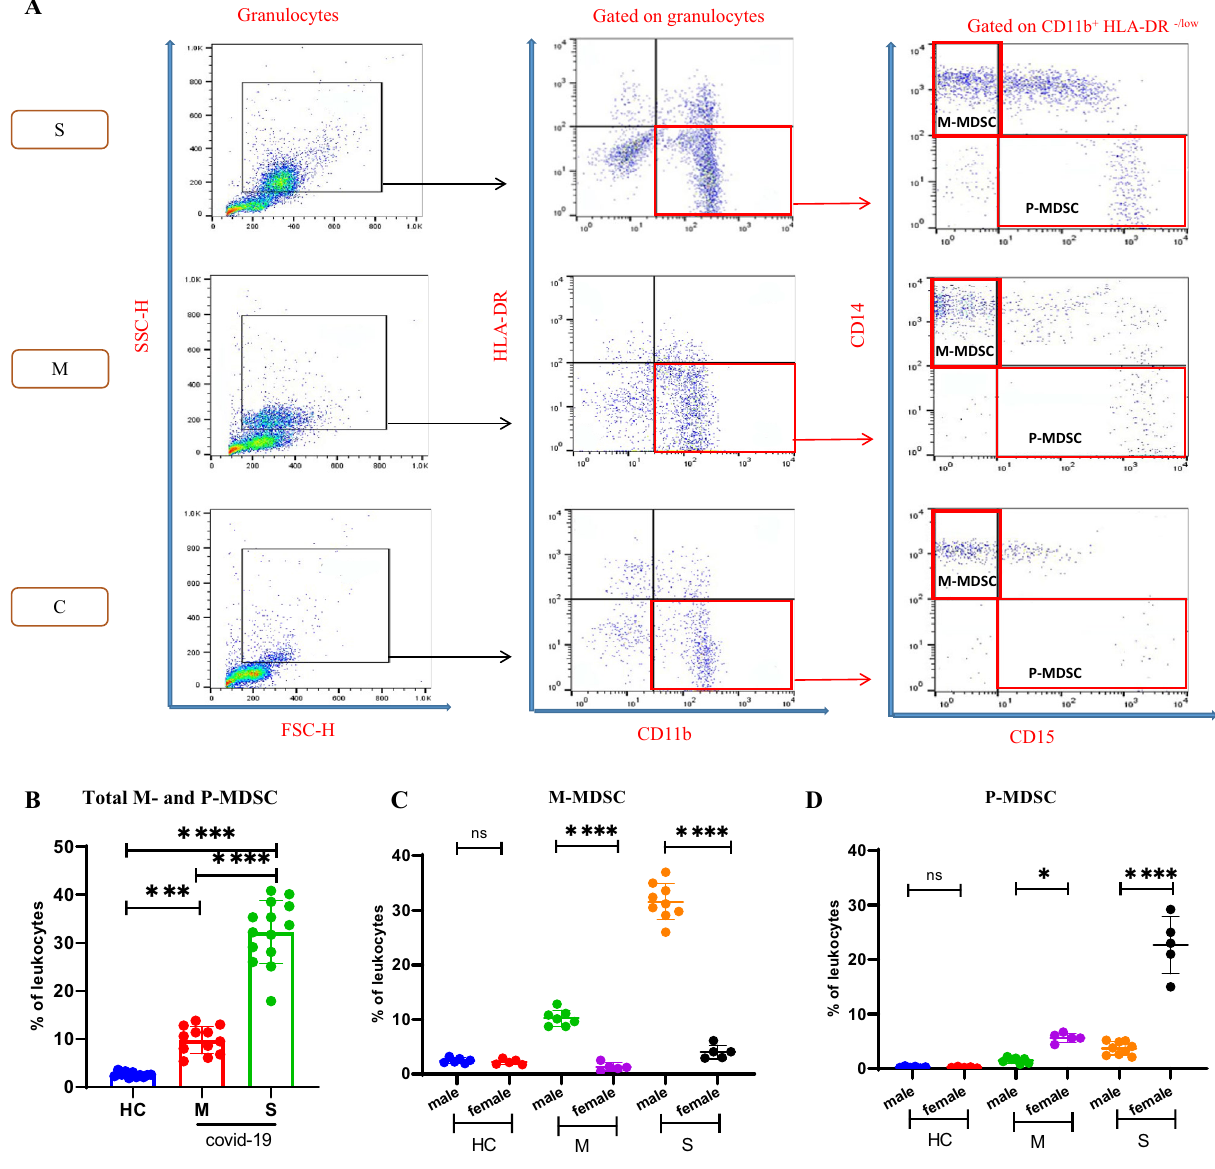
Figure 1. Analysis of circulating myeloid-derived suppressor cells (MDSCs) frequencies in patients with COVID-19. ( A ) Peripheral blood mononuclear cells (PBMCs) obtained from COVID-19 patients, healthy controls (HCs) were used to analyze MDSCs by flow cytometry. Representative dot plots of monocytic (M)-MDSCs (HLA-DR +/low CD11b + CD14 + CD15 - cells) and polymorphonuclear (P)-MDSCs (HLA-DR +/low CD11b + CD14 - CD15 + cells) identified using a gating strategy are shown in patients (severe and moderate) and control groups. ( B ) The frequencies of M- and P-MDSCs in the PBMC presented. ( C,D ) Sex differences in the frequencies of M-MDSCs and P-MDSCs between HC and moderate and severe COVID-19 patients. M-MDSCs were increased in both SMPs and MMPs, while P-MDSCs were increased in SFPs and MFPs. All values are presented as the mean or median and 5–95% percentile and comparisons made between control and patient groups were performed using ANOVA or kruskalwalis followed by a the Tukey’s or Dunn’s tests for normally distributed or non-normally distributed data respectively *P < 0.01, **P < 0.001, ***P < 0.0001 and ****P < 0.0001. HLA-DR human leukocyte antigen-D–related, HC healthy control, M moderate, S with homologous CD4 + and CD8 + T cells (Fig. 4A P = 0.02 and Fig. 4B P = 0.03, respectively) despite similar levels of induction. COVID‑19 MDSCs suppress CD4 + CD25 + Foxp3 + cells and evoke CD4 + CD25‑Foxp3 + expan‑ sion. TGF-β promotes the expansion of CD4 + CD25 + Foxp3 + regulatory T cells in vitro and in vivo 33 . Thus, we assessed the impact of MDSCs on CD4 + CD25 + Foxp3 + T in HC and COVID-19 patients. Representative FACS plots are shown in Supplementary Fig. 7 indicating the effect of co-culturing MDSCs with autologous